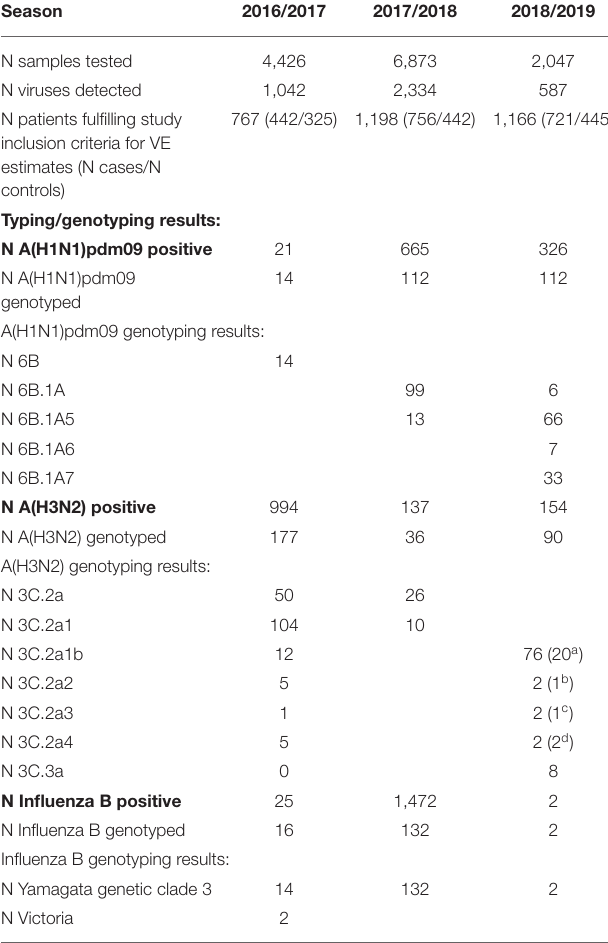
TABLE 1 | Epidemiologic characteristics of the three influenza seasons: number of samples tested, number of influenza viruses detected and detailed virus characterization results.